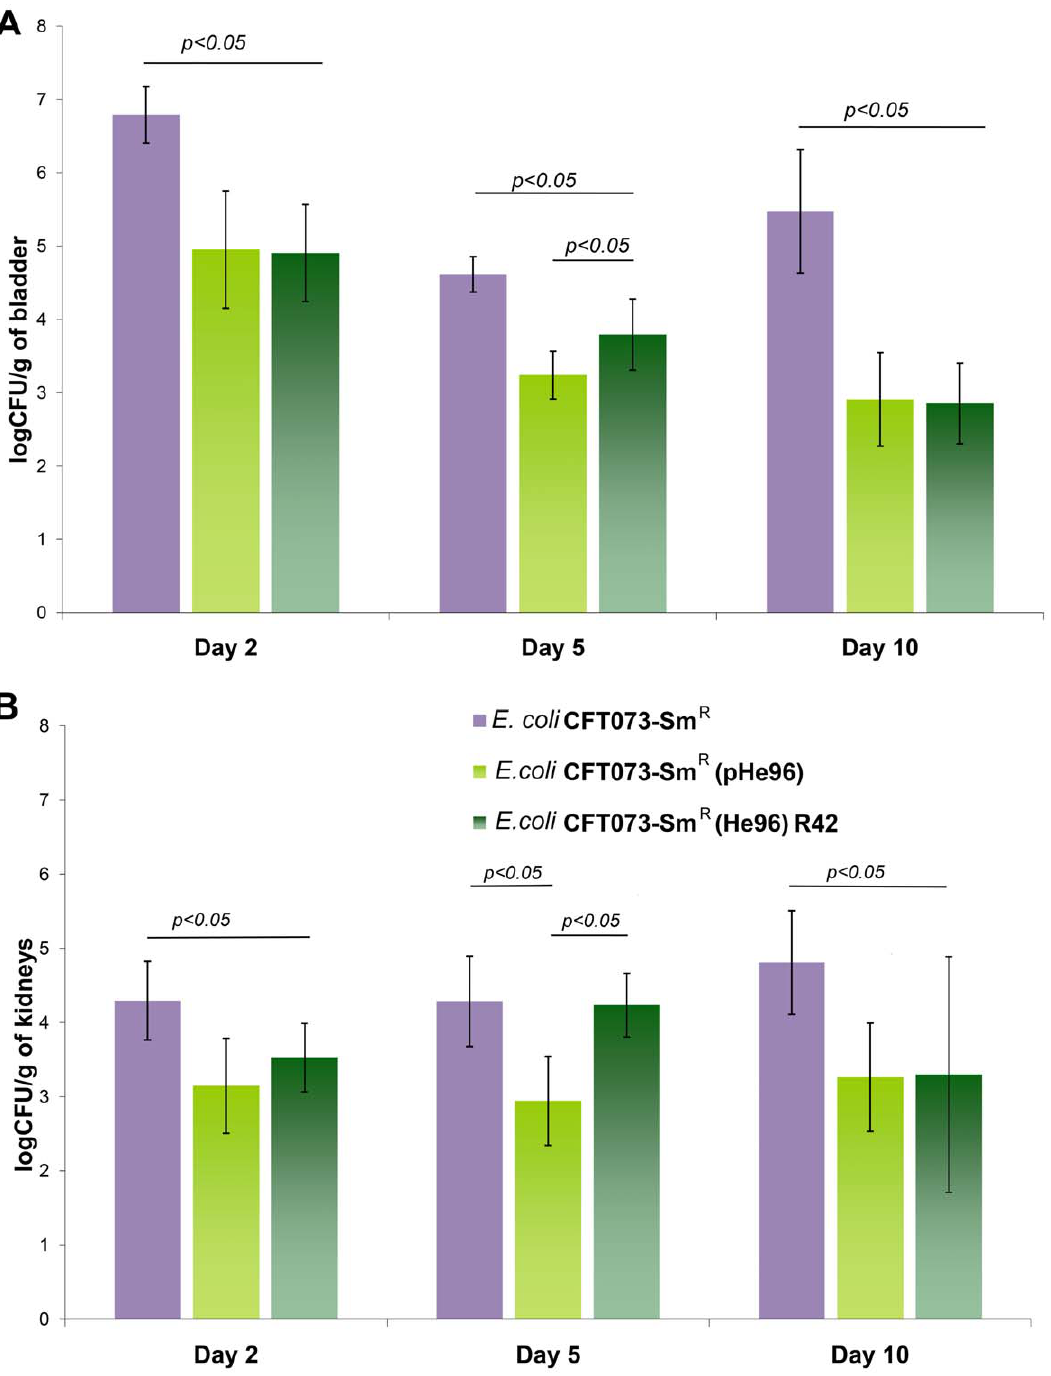
Figure 3. Single strain urinary tract infections with the isogenic system of E.coli CFT073-SmR harboring or not the multidrug resistance plasmid pHe96 ( qnrA3 ). Part A: Bacterial density (log 10 CFU/g of tissue) in bladders collected two, five and ten days after inoculation by E. coli CFT073-Sm R ( qnr 2 , purple plot), E. coli CFT073-Sm R (pHe96) ( qnrA3 + , light green plot) and E. coli CFT073-Sm R (pHe96) R42 variant ( qnrA3 + , dark green plot). At day 2, bacterial density was 6.79 + / 2 0.35, 4.95 + / 2 0.8 (p , 0.0001), and 4.9 + / 2 0.65 (p , 0.0001), respectively; at day 5, it was 4.61 + / 2 0.25, 3.24 + / 2 0.3 (p , 0.0001) and 3.79 + / 2 0.5 (p=0.03), respectively; and at day 10, 5.47 + / 2 0.8, 2.91 + / 2 0.6 (p=0.0004) and 2.85 + / 2 0.5 (p=0.001), respectively. At least 10 mice were studied per group. Part B : Bacterial density (log 10 CFU/g of tissue) in kidneys collected two, five and ten days after inoculation by E. coli CFT073-Sm R ( qnr 2 , purple plot), E. coli CFT073-Sm R (pHe96) ( qnrA3 + , light green plot) and E. coli CFT073-Sm R (pHe96) R42 variant ( qnrA3 + , dark green plot). Results were respectively 4.29 + / 2 0.53, 3.14 + / 2 0.64 (p=0.005) and 3.53 + / 2 0.46 (p=0.053) at day 2; 4.29 + / 2 0.61, 2.94 + / 2 0.6 (p=0.02), and 4.23 + / 2 0.43 (p=0.06) at day 5; and 4.81 + / 2 0.6, 3.26 + /0.63 (p=0.012 and 3.3 + / 2 1.59 (p=0.04) at day 10. At least 10 mice were studied per group.